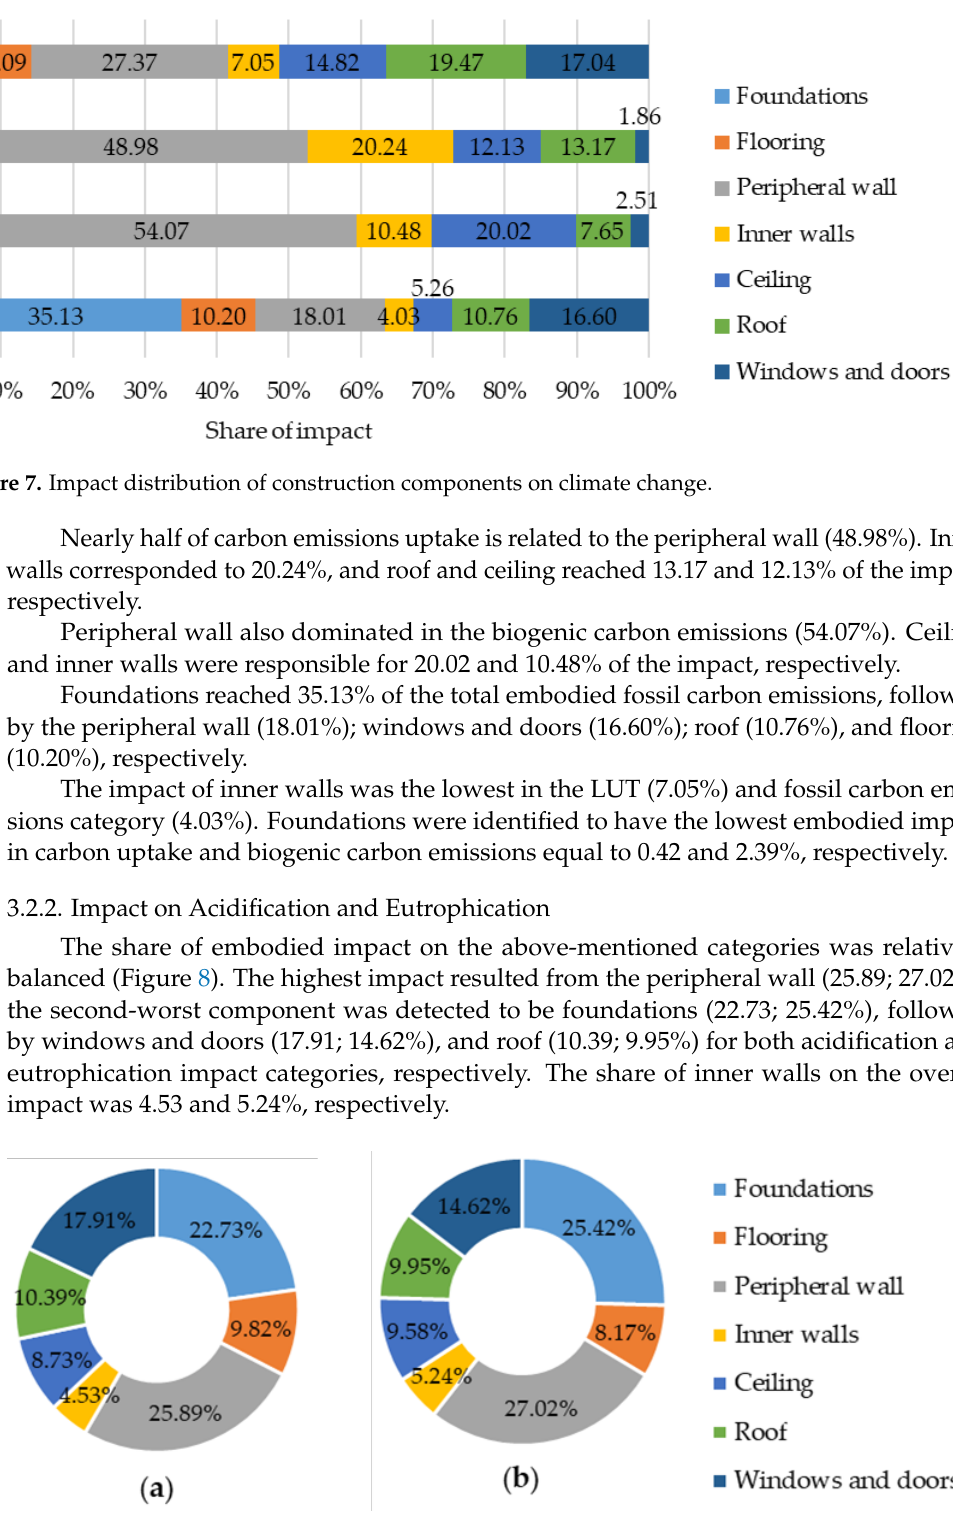
Figure 9. Impact distribution of construction components on photochemical oxidation. 3.2.4. Impact on Water Scarcity Most of the embodied water consumption was assigned to the peripheral wall (60.30%) (Figure 10). Ceiling accounted for 20.91%, and foundations were responsible for 9.12% of the impact, respectively. Other components reached less than 4% of the impact, each leaving the inner walls the least damaging part of the studied construction. Figure 10. Impact distribution of construction components on water scarcity.